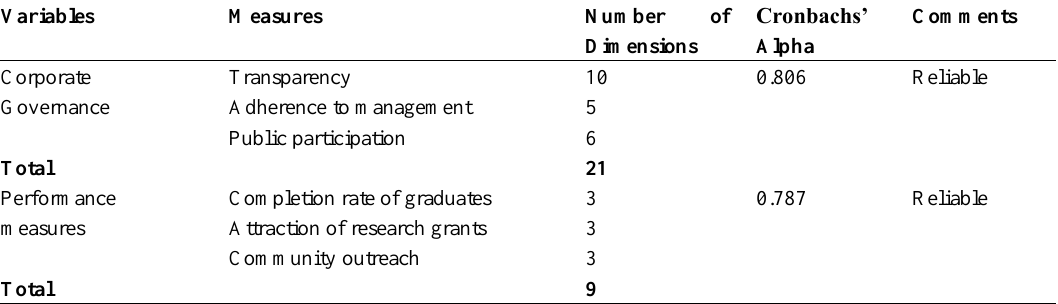
Table 3: Validity and Reliability